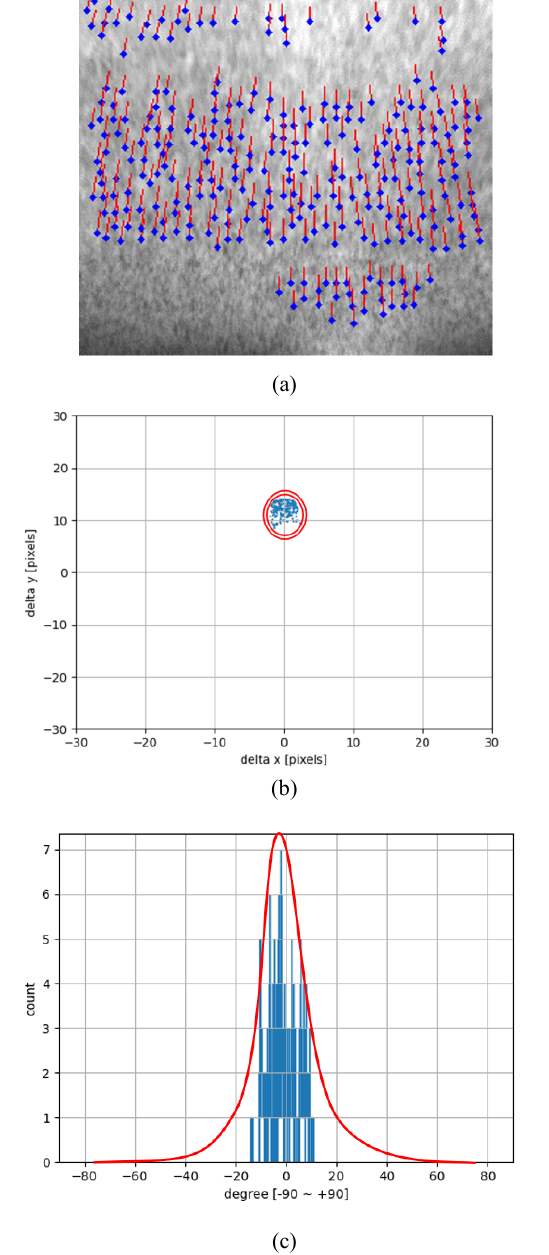
Figure 11 . (a) Unfiltered motion vectors obtained from the Ground Plane Image (b) An x-y plot of motion vectors. (c) The histogram on angles of motion vector